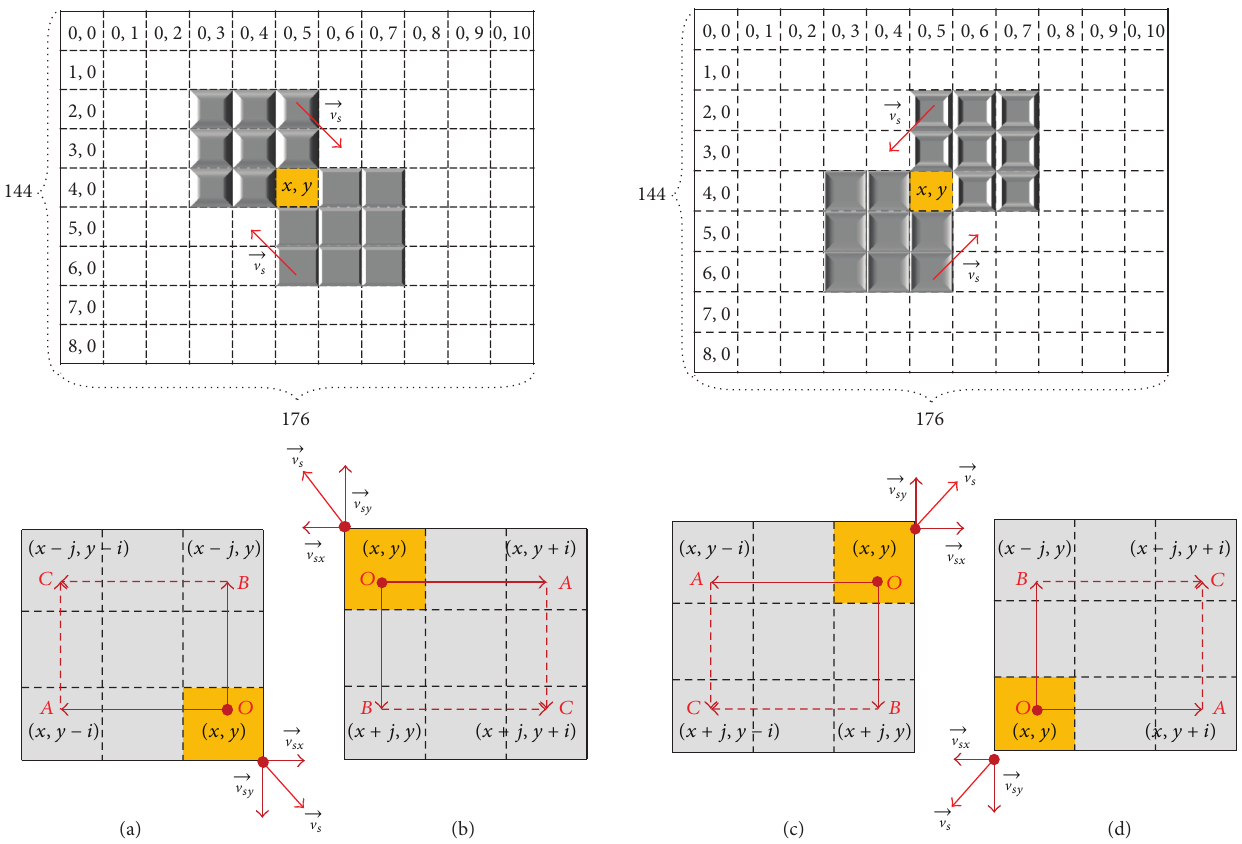
Figure 1: Schematic diagram of motion reference region 𝐶 𝑟𝑟